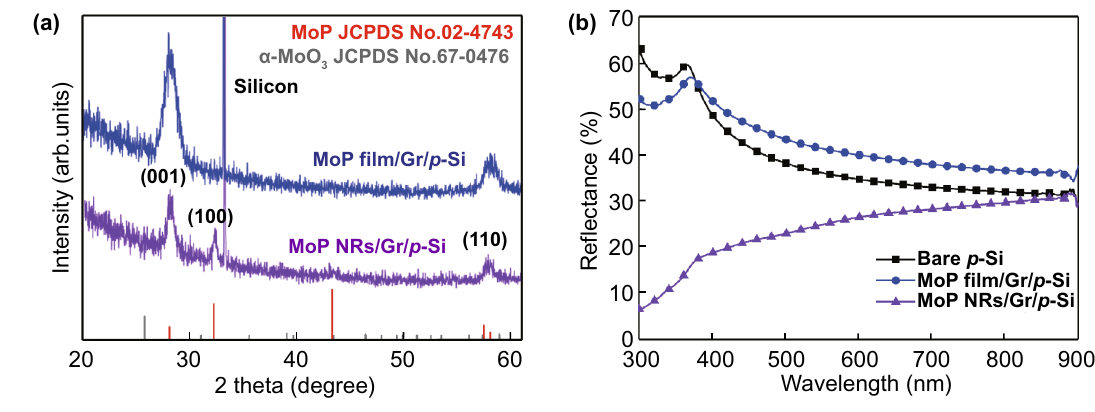
Fig. 3 a XRD spectra. b Reflectance versus wavelength spectra of bare p‑Si, MoP film/Gr/p‑Si, and MoP